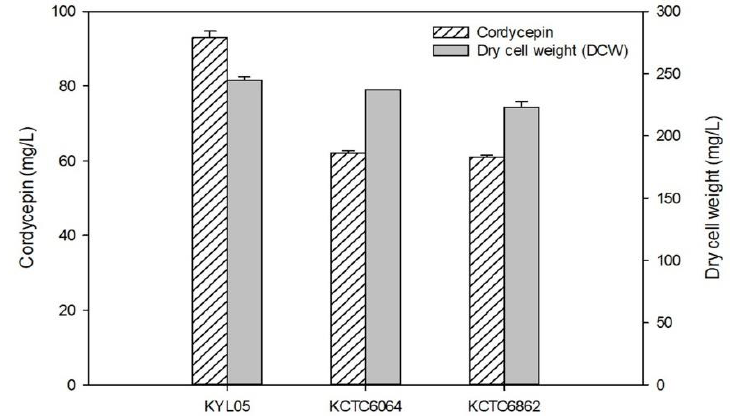
Figure 1. Cordycepin production and dry cell weight from C. militaris by three strains. Figure 1. cordycepin production and dry cell weight from C. militaris by three